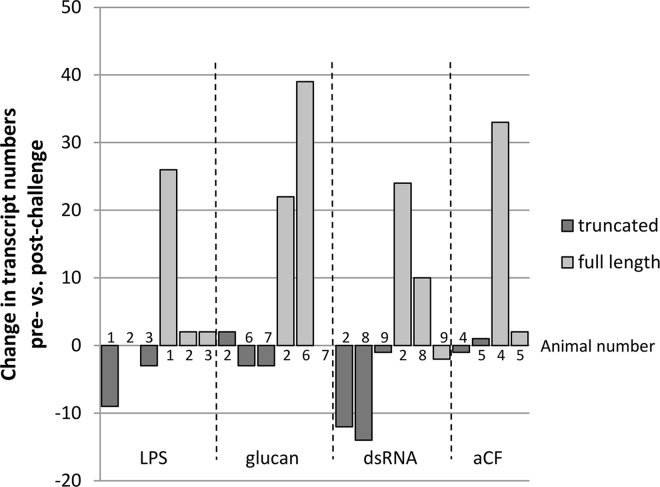

Sp185/333 mRNA editing decreases in response to immune challenge.
Sp185/333 cDNA sequences reported by Terwilliger et al. [7] were evaluated for the change in the number sequences encoding truncated vs. full-length Sp185/333 proteins post-challenge compared to pre-challenge with LPS, β,1–3,glucan (glucan), double stranded RNA (dsRNA), or artificial coelomic fluid (aCF, buffer, sham injection control). Bars that appear to be missing indicate 0 change. Nine sea urchins (indicated by number) were used in the analysis and animal 2 was evaluated for multiple types of challenges.